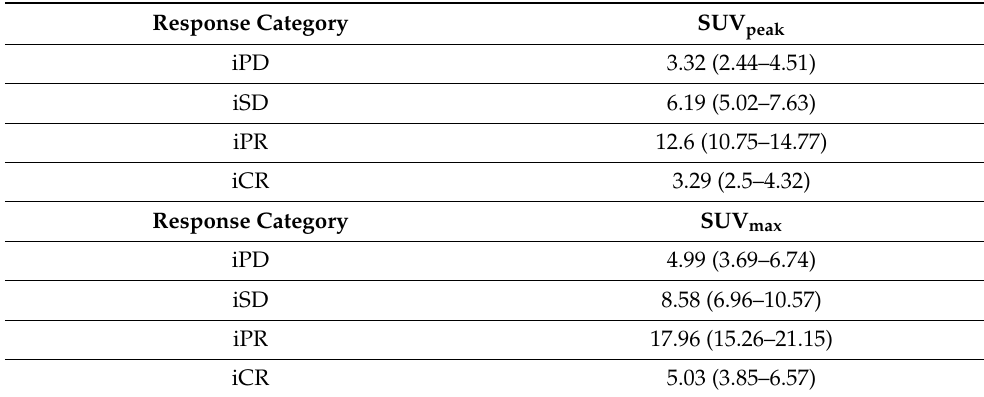
Table 5. Geometric means pre-treatment SUV peak and SUV max of imaging-based response on the